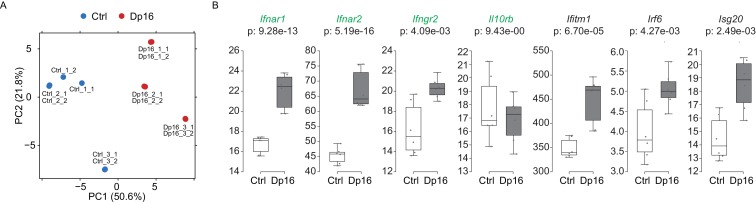
Components of the IFN response are activated in a mouse model of Down syndrome.(A) Principal component analysis (PCA) of RNA-seq samples produced from lineage negative, Sca1 positive, c-kit positive (LSK) cells from Dp16 mice and matched littermate controls. (B) Box and whisker plots of RNA expression for the four IFN receptor subunits encoded on chr16 (green) and representative IFN-related genes from Dp16 LSK cells. mRNA expression values are displayed in reads per kilobase per million (RPKM). Benjamini-Hochberg adjusted p-values were calculated using DESeq2.